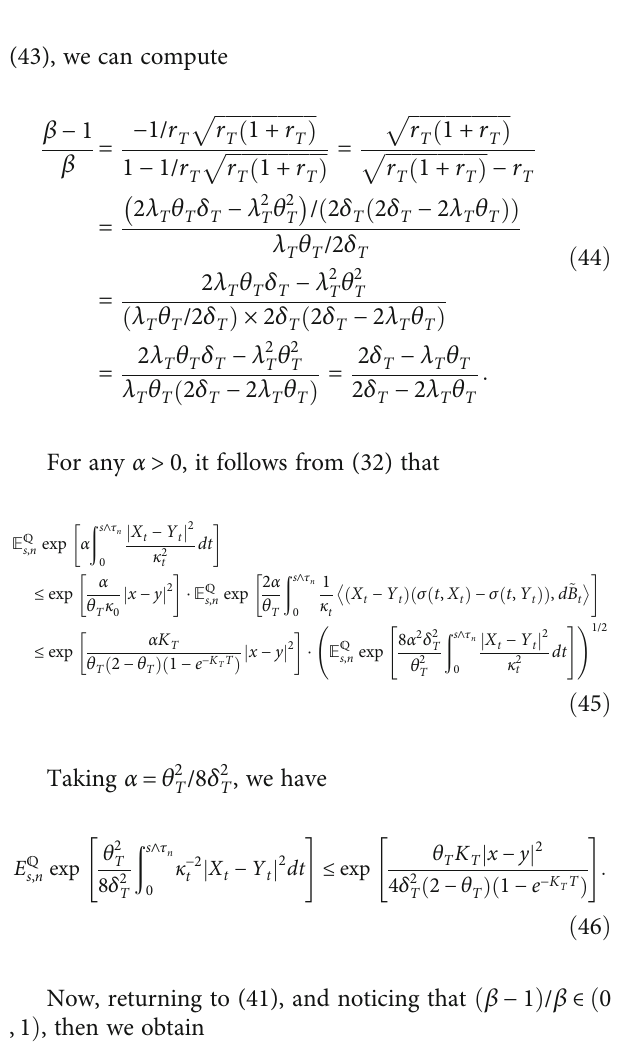
T ð ffiffiffiffiffiffiffiffiffiffiffiffiffiffiffiffiffiffiffiffi